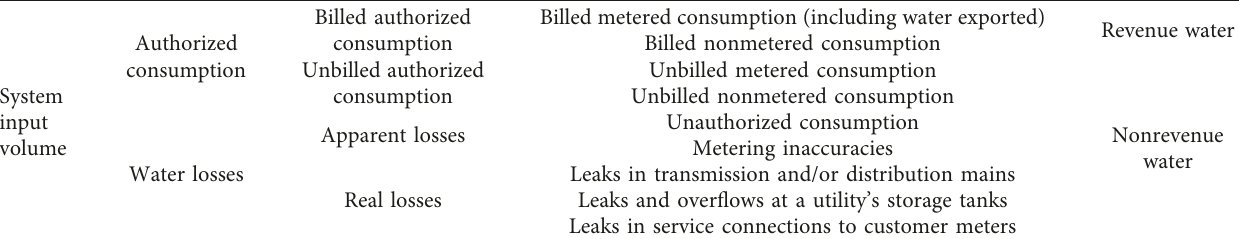
Table 1: Components of water balance [14, 15,